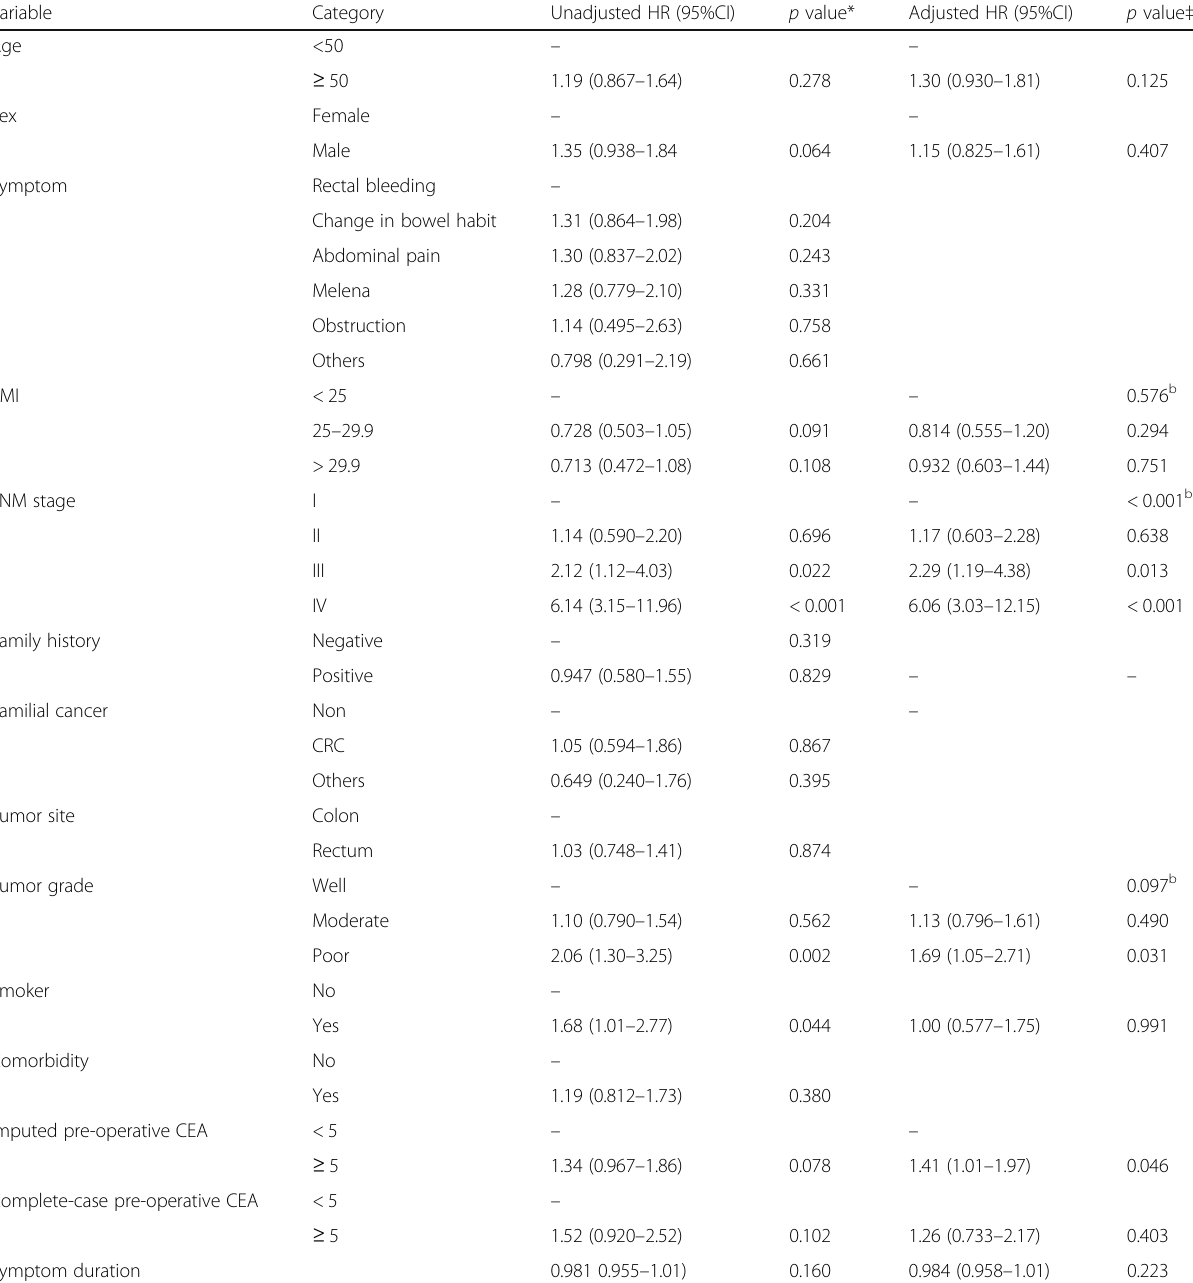
Table 2 Univariate and Cox proportional hazards model of patient and clinicopathological factors influencing overall survival